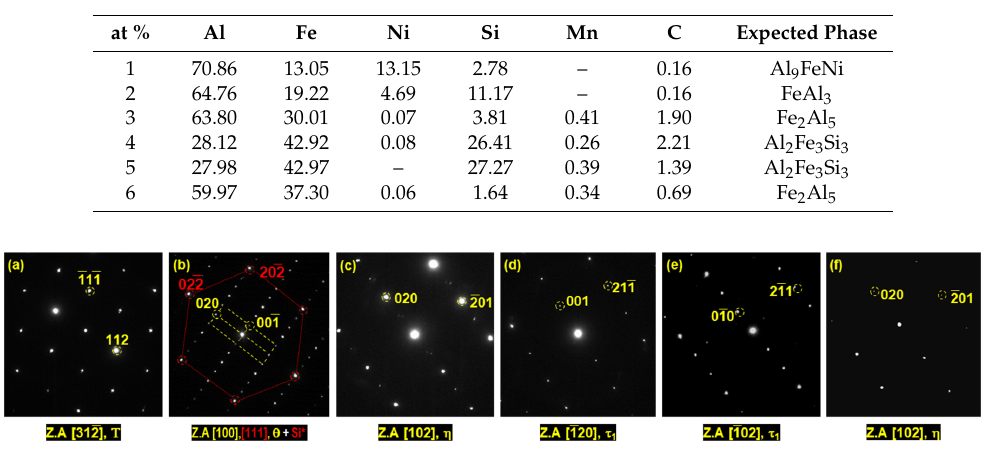
Figure 8. STEM results showing the FIB specimen extracted from the area denoted by X 2 in Figure 5. ( a ) HAADF Image; ( b – g ) Results of EDS ( b ) Al, ( c ) Ni, ( d )b Si, ( e ) Fe, ( f ) Mn, ( g ) C; and ( h ) high magnification images of No. 2. Table 4. EDS results and suggested phases in the areas denoted as 1–6 in Figure 8a.